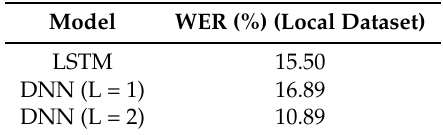
Table 7. WER of models tested on locally generated data.